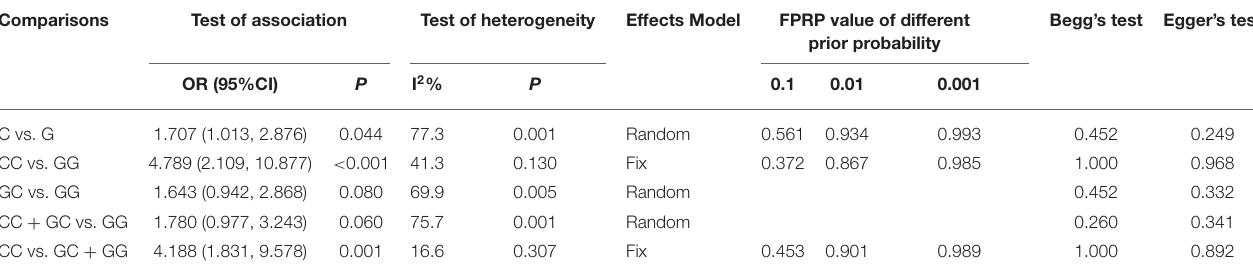
TABLE 3 | Summary of the association between MIF -173G > C polymorphism and INS steroid responsiveness.